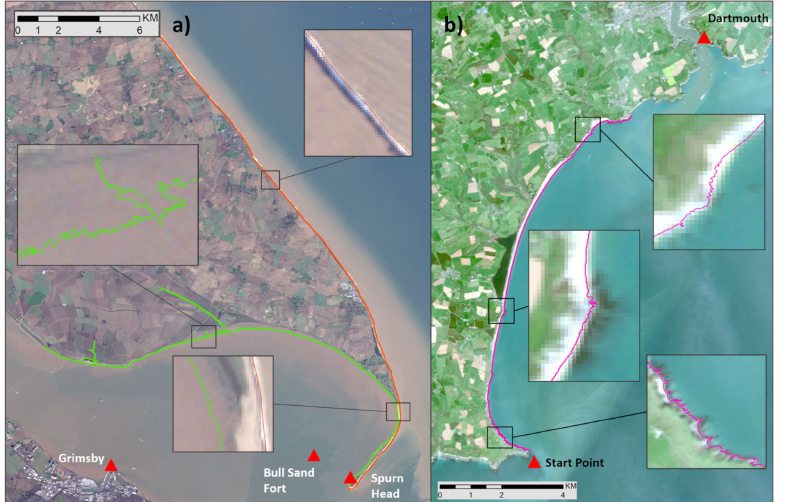
Figure 6. Datum-based tidelines extracted from SurfZone DEMat; ( a ) for Site #1 (red), Site #2 (green) and ( b ) Site #3 (magenta). Approximate location of tide gauge stations available in POLTIPS3 also shown with red triangles. Source of aerial imagery: Sentinel-2 MSI images taken 3 December 2019 at 11:13 UTM for Spurn Head and 20 April 2019 at 11:21 UTM for Start Bay. Copernicus Sentinel data 2019.